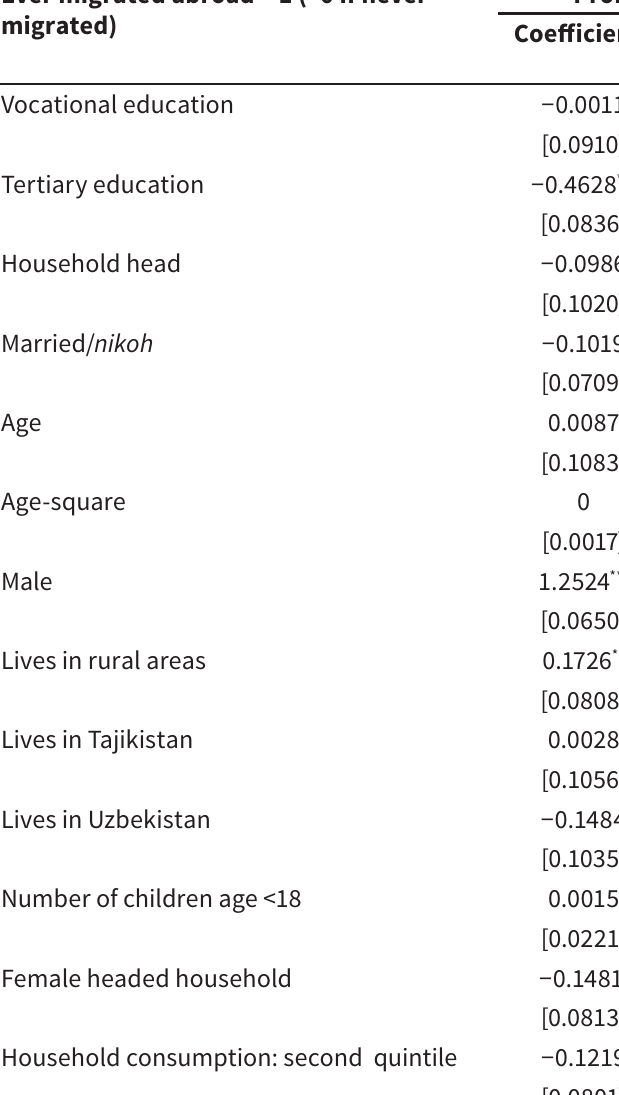
Probit and heteroscedastic probit regressions on decision of migration Ever migrated abroad = 1 ( = 0 if